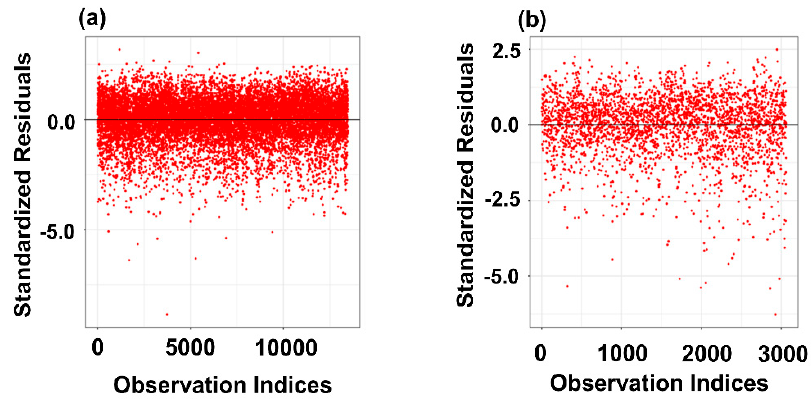
Figure 5. Standardized Residual Plots for ( a ) plant I and ( b ) plant II.